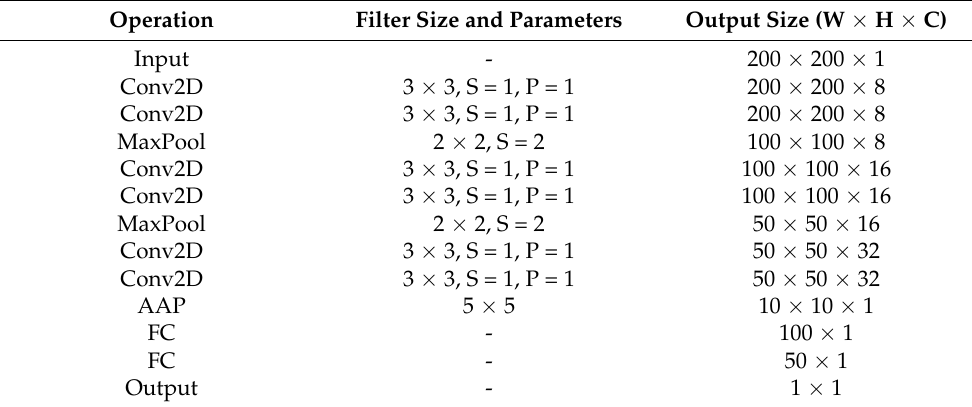
Table 2. Network architecture of the microstructure–property linkage module. Operation